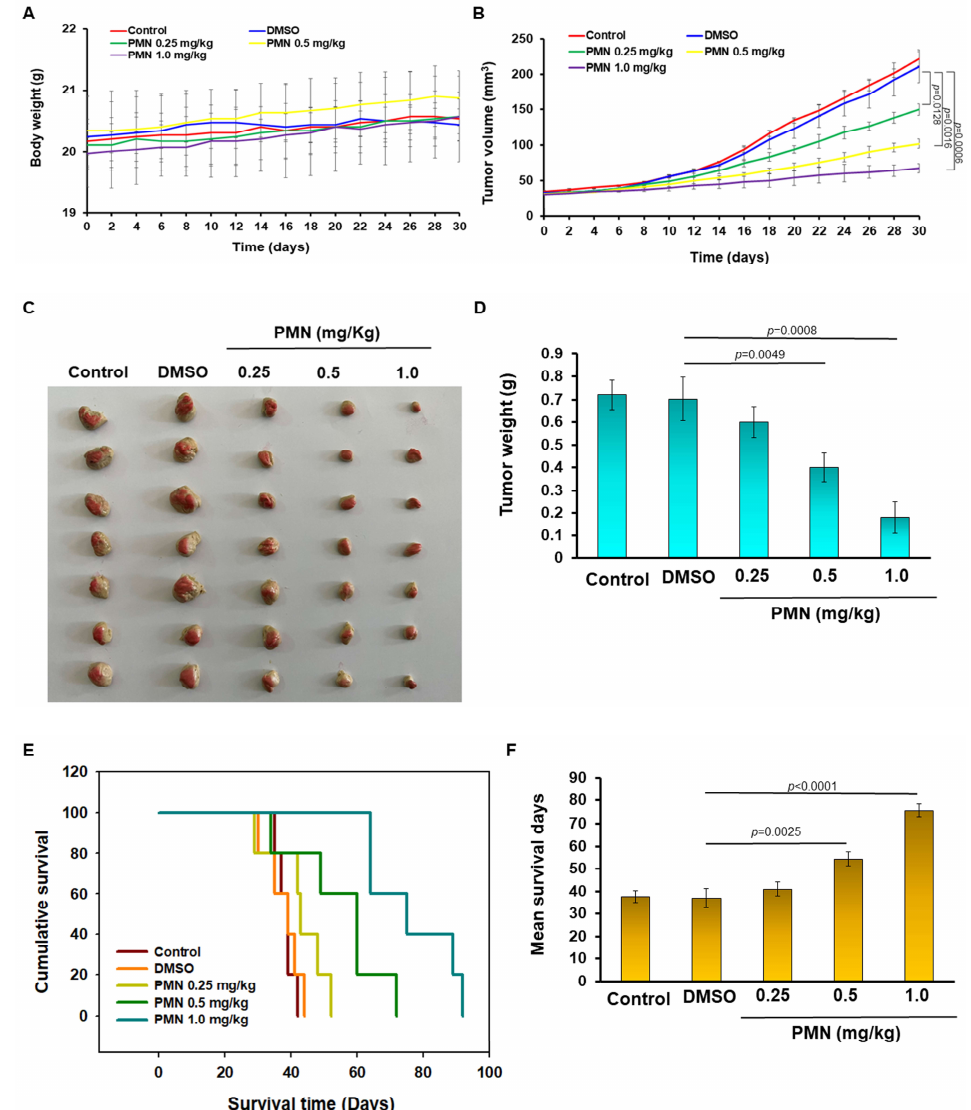
Figure 9. PMN treatment inhibits tumor growth in a nude mice model of dorsal subcutaneous GBM xenografts. The dorsal side of male nude mice were inoculated subcutaneously with GBM8401 cells. After tumor formation, drug injection and tumor growth analysis were performed. Mice received intraperitoneal injections of saline, DMSO, 0.25 mg/kg PMN, 0.5 mg/kg PMN and 1.0 mg/kg PMN, respectively, on days 10, 13 and 16 after tumor development ( n = 6). ( A ) The weight of mouse body was continuously recorded every 2 days during the experiment. The results showed that there was no significant change in the average body weight of the mice in each group. ( B ) During the experiment, the tumor volume of mice in each group was measured every 2 days to obtain tumor growth curves. The results showed a dose-dependent slowdown of tumor growth in PMN-treated mice compared with the control group. ( C ) On day 30 of the experiment, mice were sacrificed and tumors were excised for analysis. The results indicated that PMN treatment dose-dependently diminished tumor size in mice. ( D ) In tumor-bearing mice, the weight of tumor was significantly lighter in the PMN group compared with the DMSO group. ( E ) Evaluation of the median survival of mice in each group. ( F ) The median survival day of PMN-treated tumor-bearing mice was dose-dependently prolonged compared to the DMSO group.